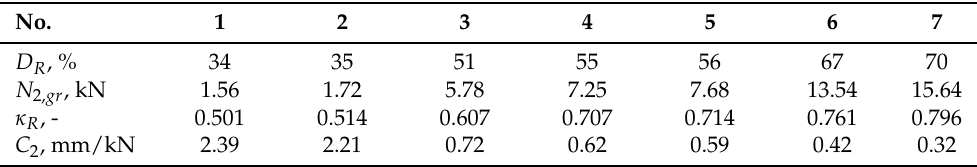
Table 5. Parameters of settlement curves and resistances mobilization curves of the investigated piles (based on Equations (3)–(5)).